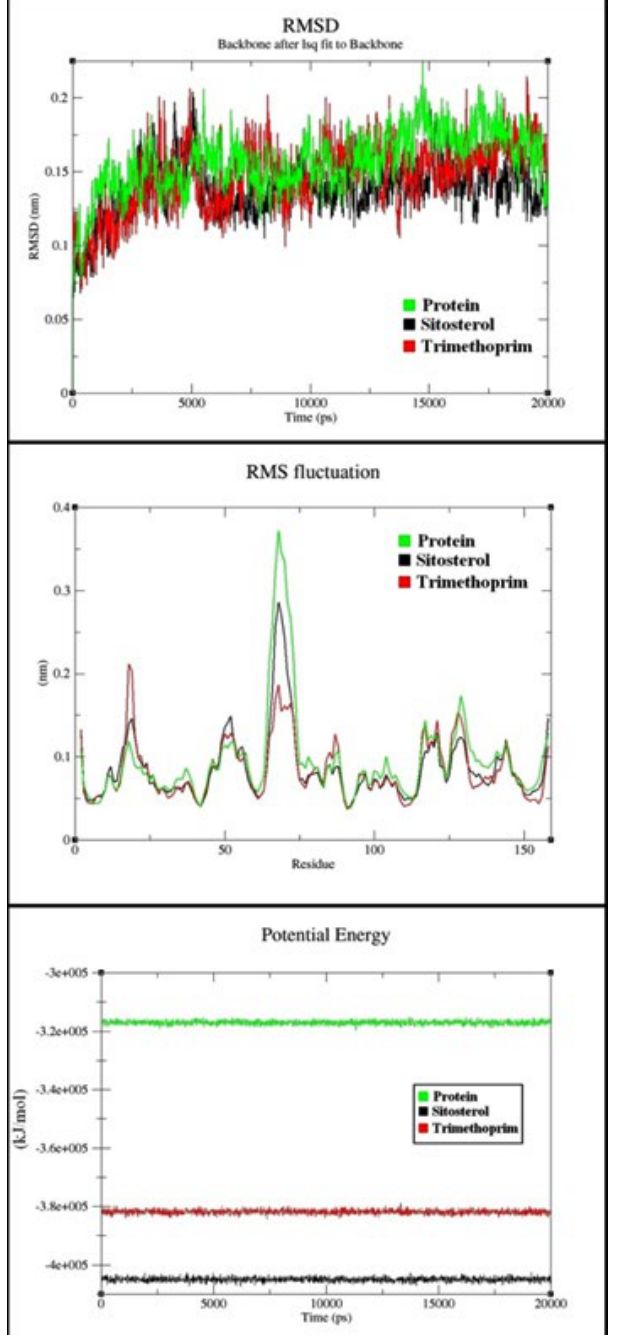
Fig. 7. RMSD, RMSF and Potential energy analysis of MD